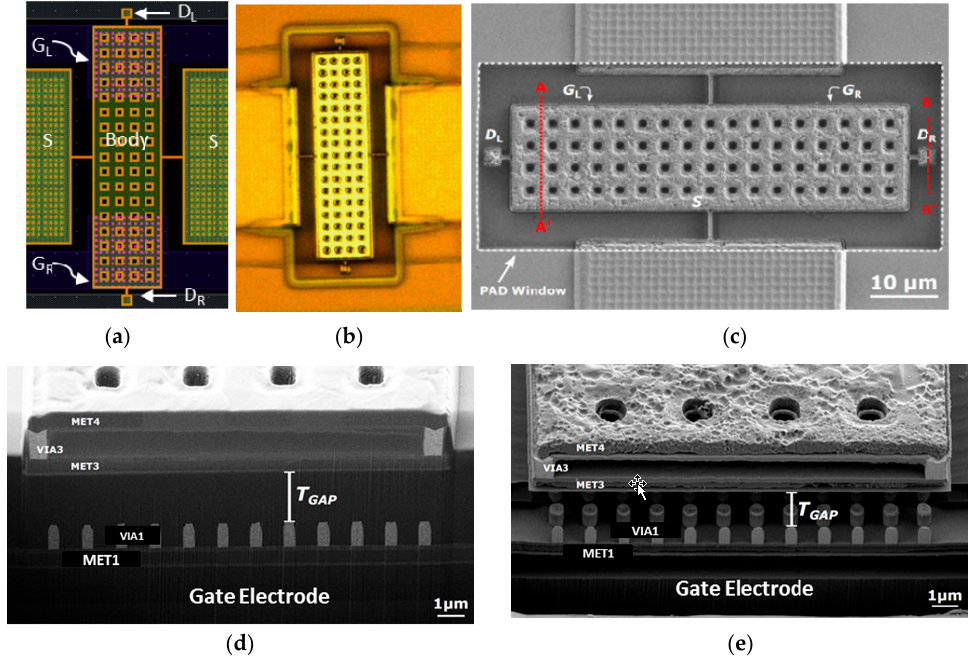
Figure 2. ( a ) Layout of the seesaw relay. The gate electrodes are the pink areas below the body structure. ( b ) Top view optical image of fabricated and released seesaw relay. ( c ) Top view SEM image indicating the cut-line A-A ′ over the body structure and B-B’ over the contact area. ( d , e ) SEM images of the cross-section in the A-A ′ cut-line (d) before and (e) after the releasing process. These images allow one to see the gate electrodes composed by the MET1 and VIA1 layers, as well as the sandwiched composition of the body element of the relay (a sandwich of MET3-VIA3-MET4).